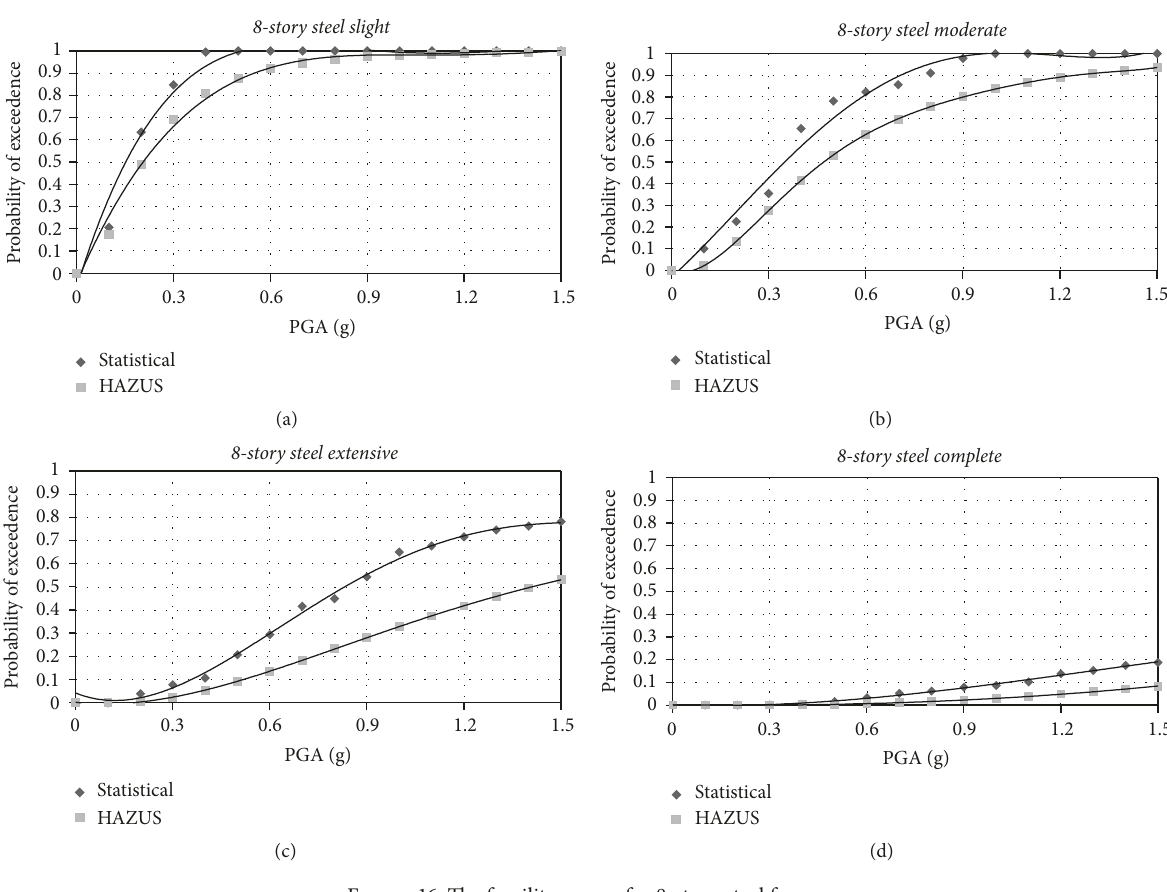
Figure 16: The fragility curves for 8-story steel